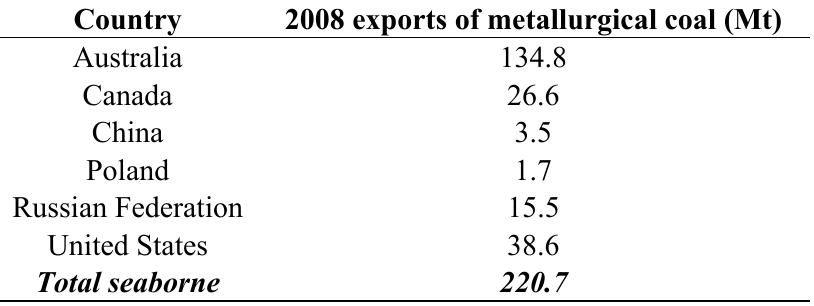
Table 4. Metallurgical coal exports [15].